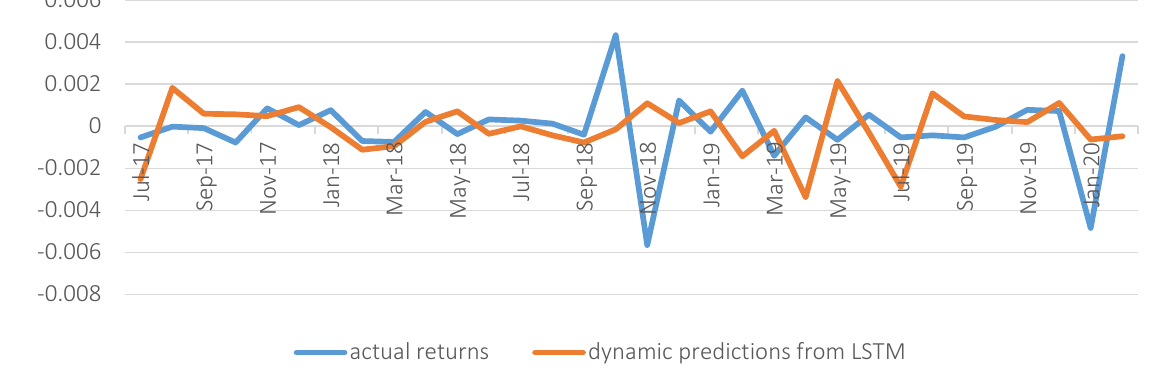
Figure 3. Dynamic forecasts from LSTM vs. actual returns